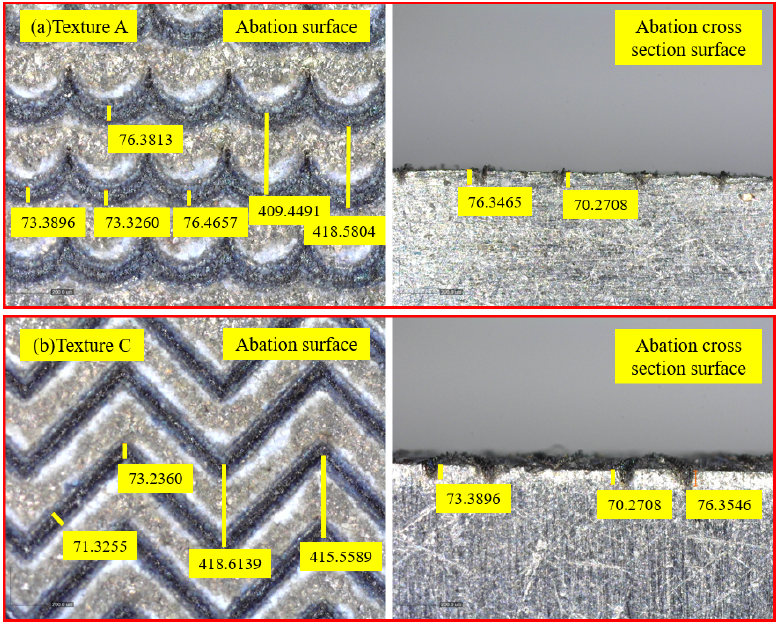
Figure 3. Actual size of laser textures observed by electron microscopy ( a ) texture A; ( b ) texture C.